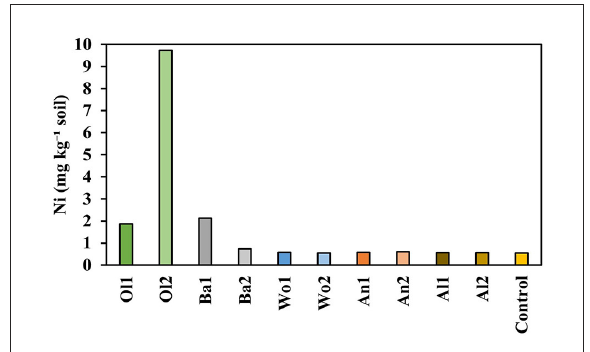
FIGURE5 Geochemically reactive soil Ni concentrations at the end of the experiment, based on 0.43M HNO 3 extraction.